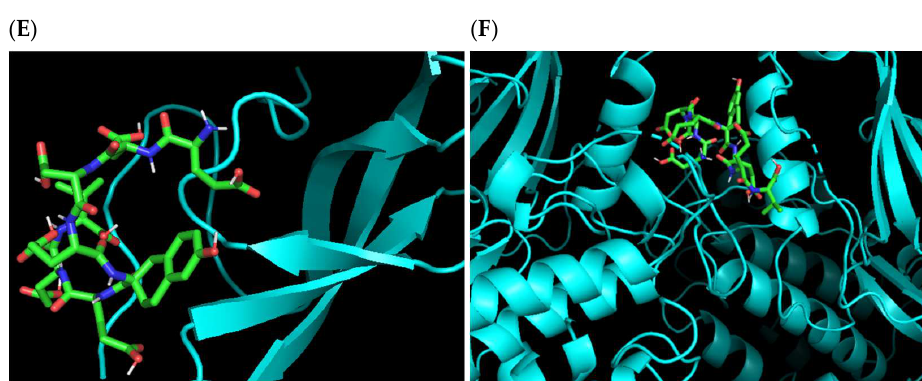
Figure 9. The molecular docking results of the binding mode of three compounds in their respective binding sites. ( A , B ) show the binding modes of vorinostat with HDAC1 (PDB: 7SME) and DNMT1 (PDB: 7LMM). ( C , D ) show the binding modes of citarinostat with CREBBP (PDB: 7XHE) and KDM6B (PDB: 2XXZ). ( E , F ) show the binding modes of compound CHEMBL375661 with DNMT1 (PDB: 7LMM) and PRKCB (PDB: 210E).